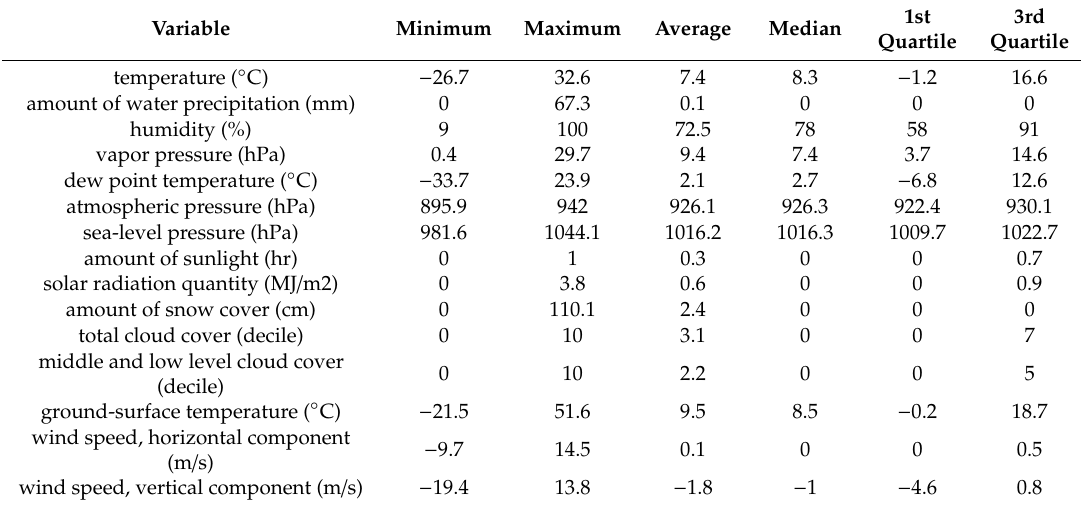
Table 9. Basic statistics for hourly data in mountainous area (Daegwalleong).